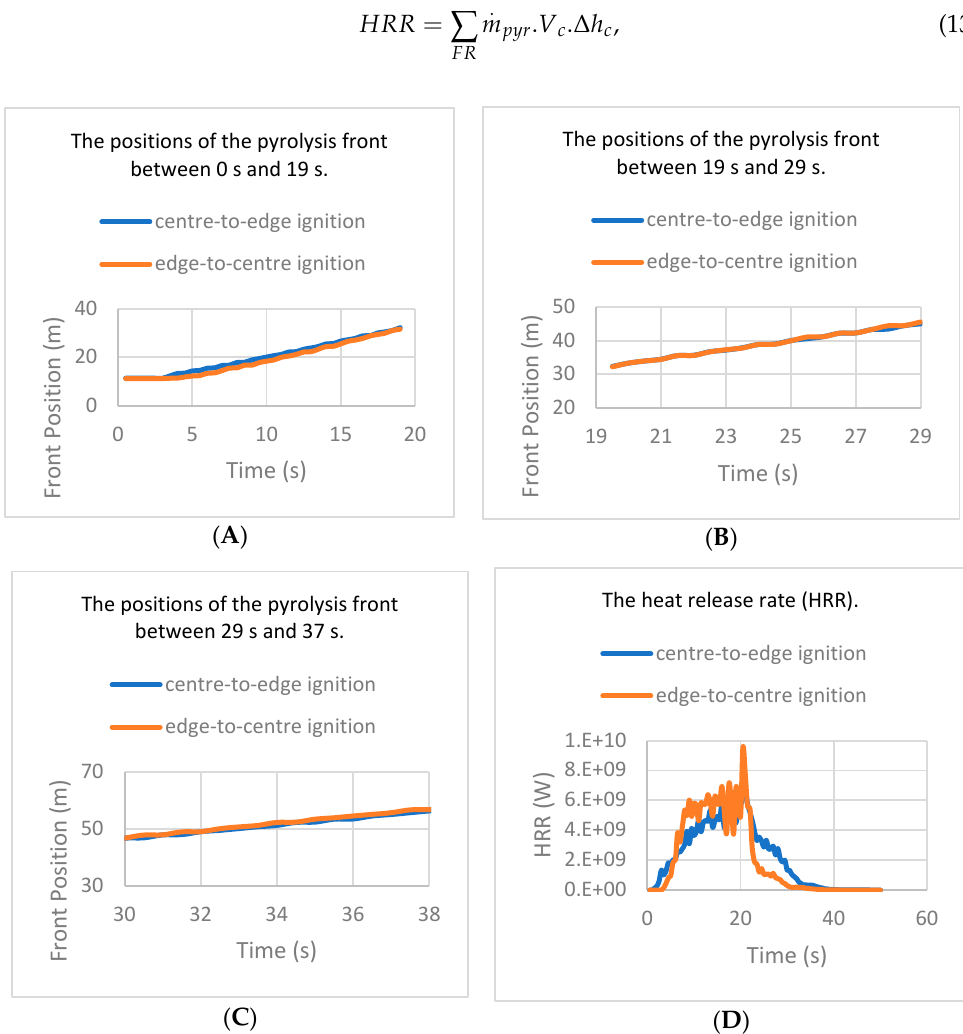
Figure 6. Comparison of predicted fire front positions and heat release rates for the two ignition procedures. ( A ) The positions of the pyrolysis front between 0 s and 19 s. ( B ) The positions of the pyrolysis front between 19 s and 29 s. ( C ) The positions of the pyrolysis front between 29 s and 37 s. ( D ) The heat release rate (HRR).